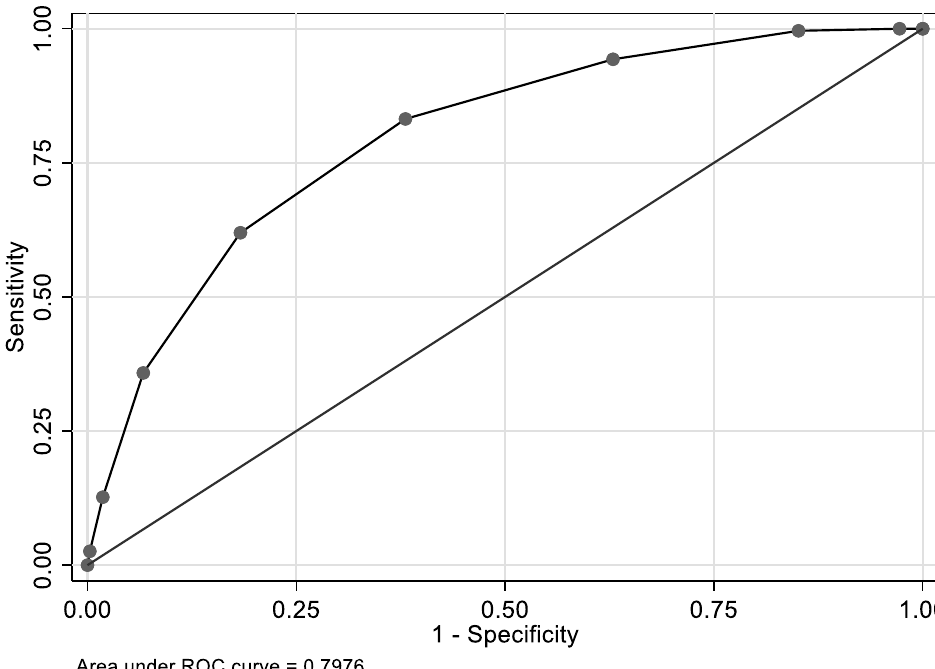
Figure 3. Eight-marker index (Index II) and its predictive value of elevated Hcy: pooled NHANES 1 . 1 n = 13,920; optimal cut-point at 5; AUC = 0.798; 95% CI: 0.783,0.812. The index consisted of a summation of all binary Index I biomarkers (See Figure 2 footnotes for cut-points), excluding blood cotinine, which was not available in HANDLS.